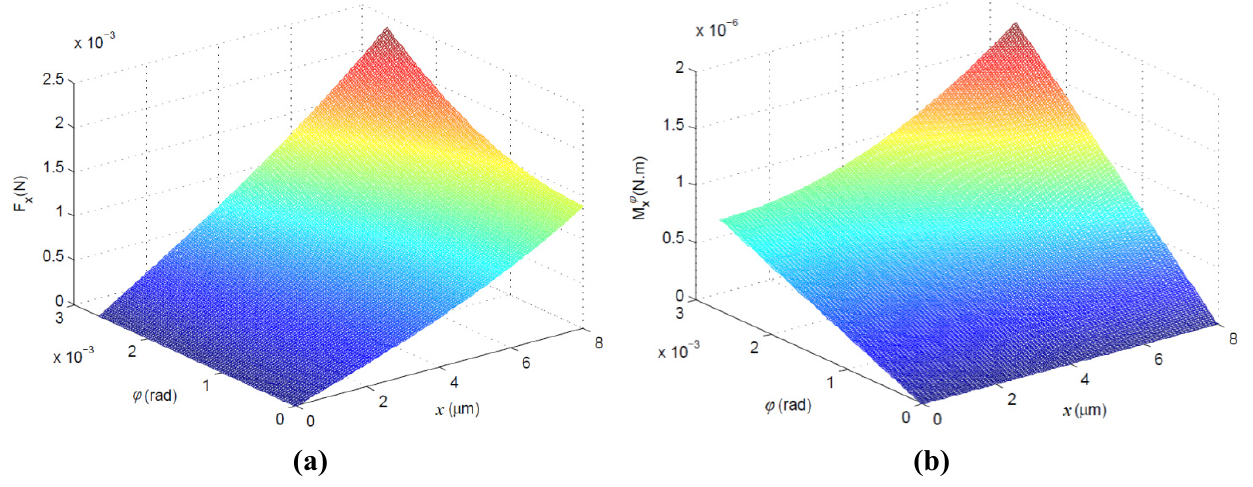
Figure 3. Surface plots of (a) electrostatic force F X ( x , φ ) of formula (21) and φ ( x , φ ) of formula (30) for an ESMA with (b) electrostatic moment M x